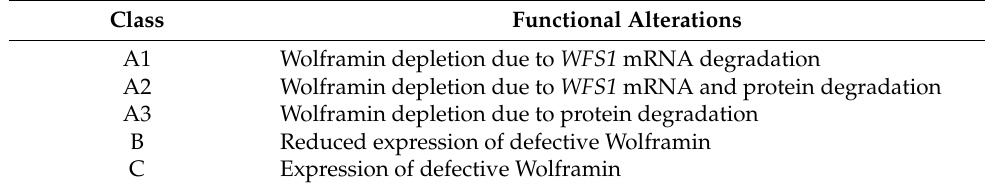
Table 3. Functional alterations of Wolframin [23]. Adapted from Rigoli et al.